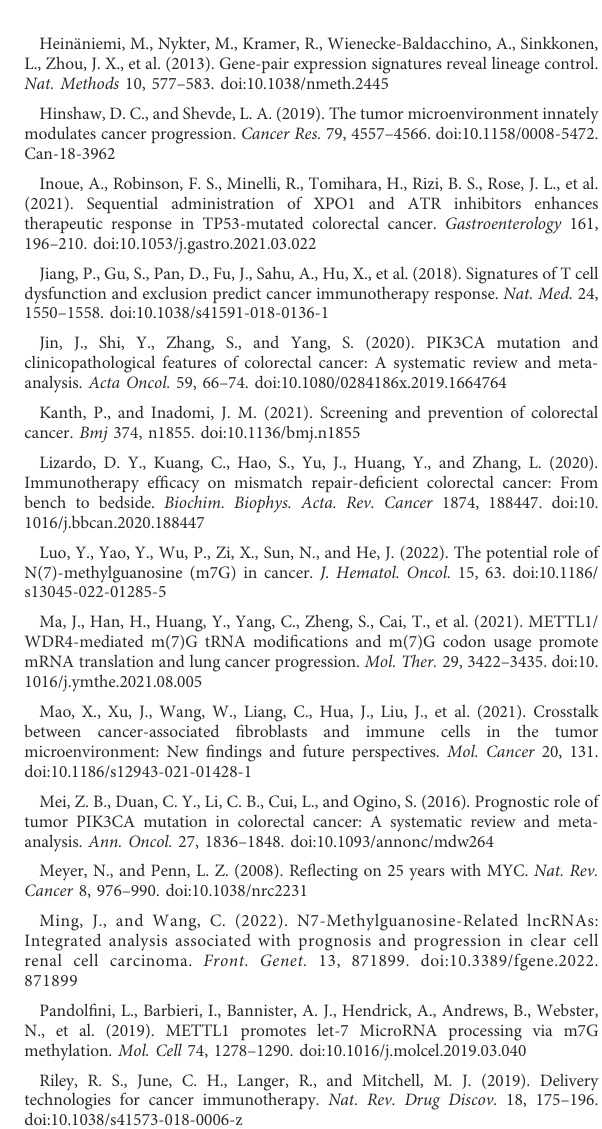
SUPPLEMENTARY FIGURE S1 Univariate Coxregressionanalysis ofthevariables affectingtheprognosis of CRC